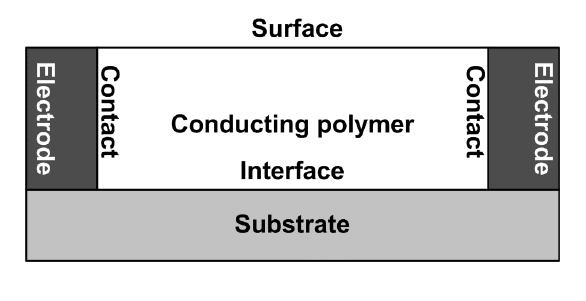
Figure 3. Configuration of